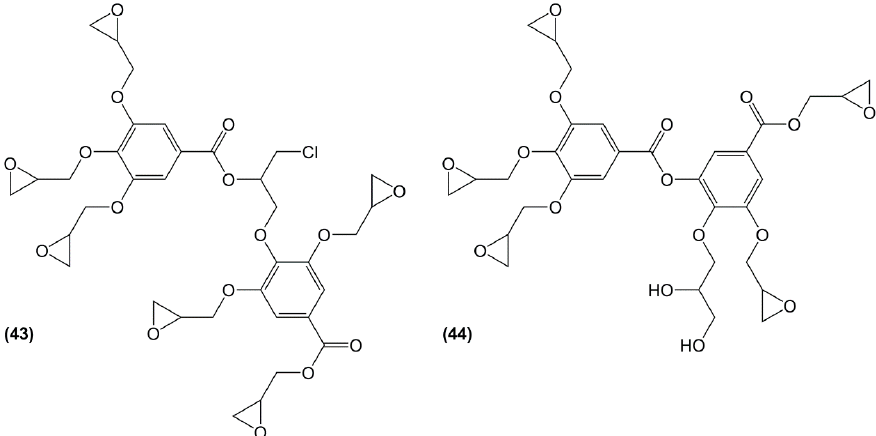
Figure 26. Main oligomers obtained from the glycidylation of depolymerized tara tannins by Aouf et al. [176].